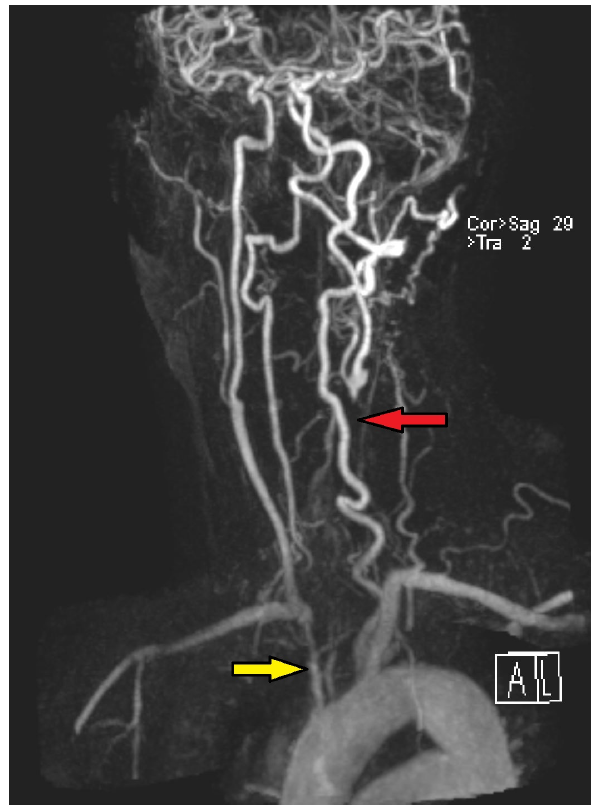
Figure 4: MRA extracranial showing severe narrowing of the origin of the right brachiocephalic artery (yellow arrow) and complete occlusion of the left common carotid artery with distal reconstitution of flow near the bifurcation (red